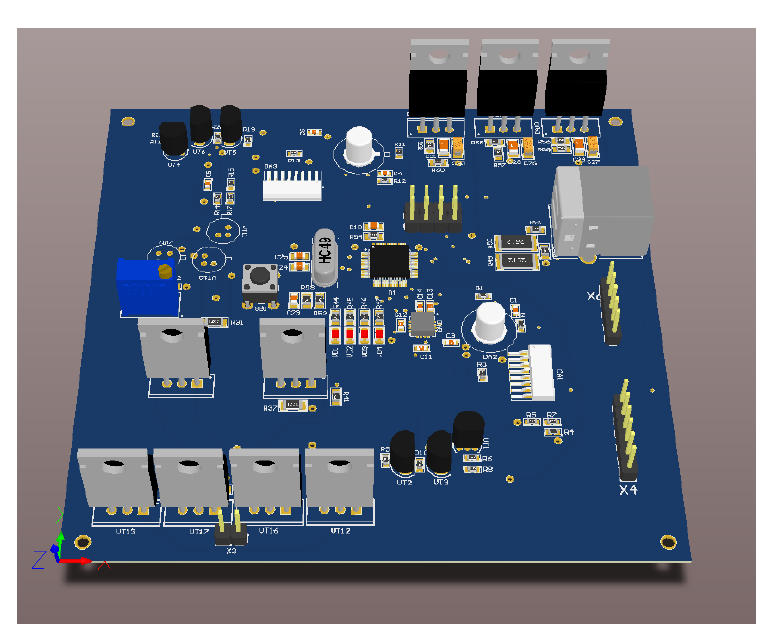
Fig. 3. A 3D view of the inertial navigation